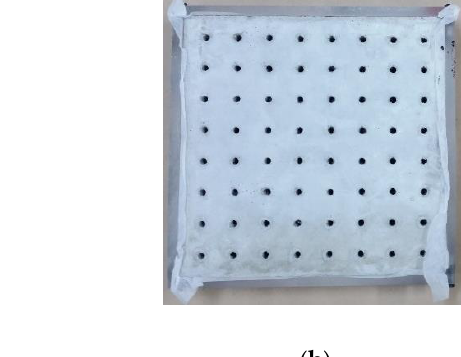
Figure 4. Proposed specimen structure, ( a ) base body dimensions, ( b ) completed specimen base.